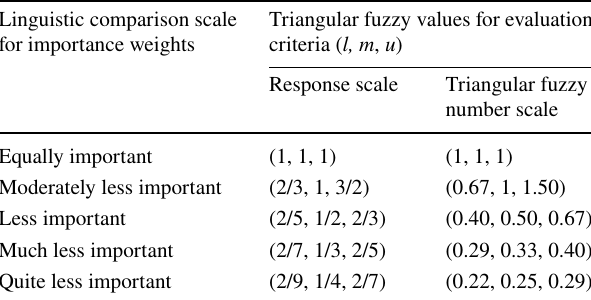
Table 2 Linguistic comparison scale triangular fuzzy values for